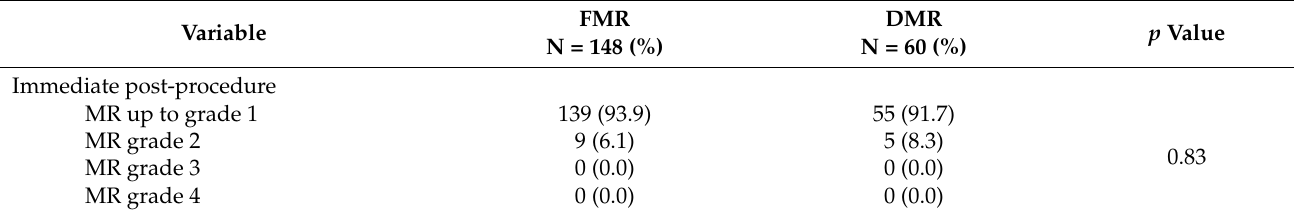
Table 3. Clinical outcomes during